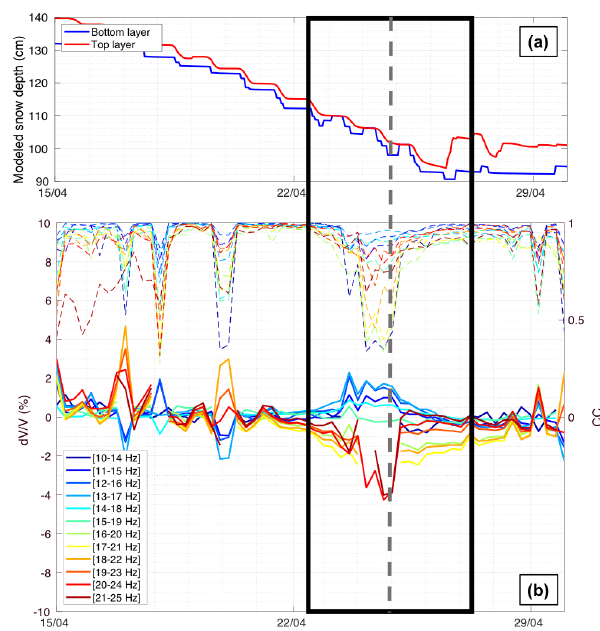
Figure 8. Same legend as Fig. 6, for snowmelt event 0